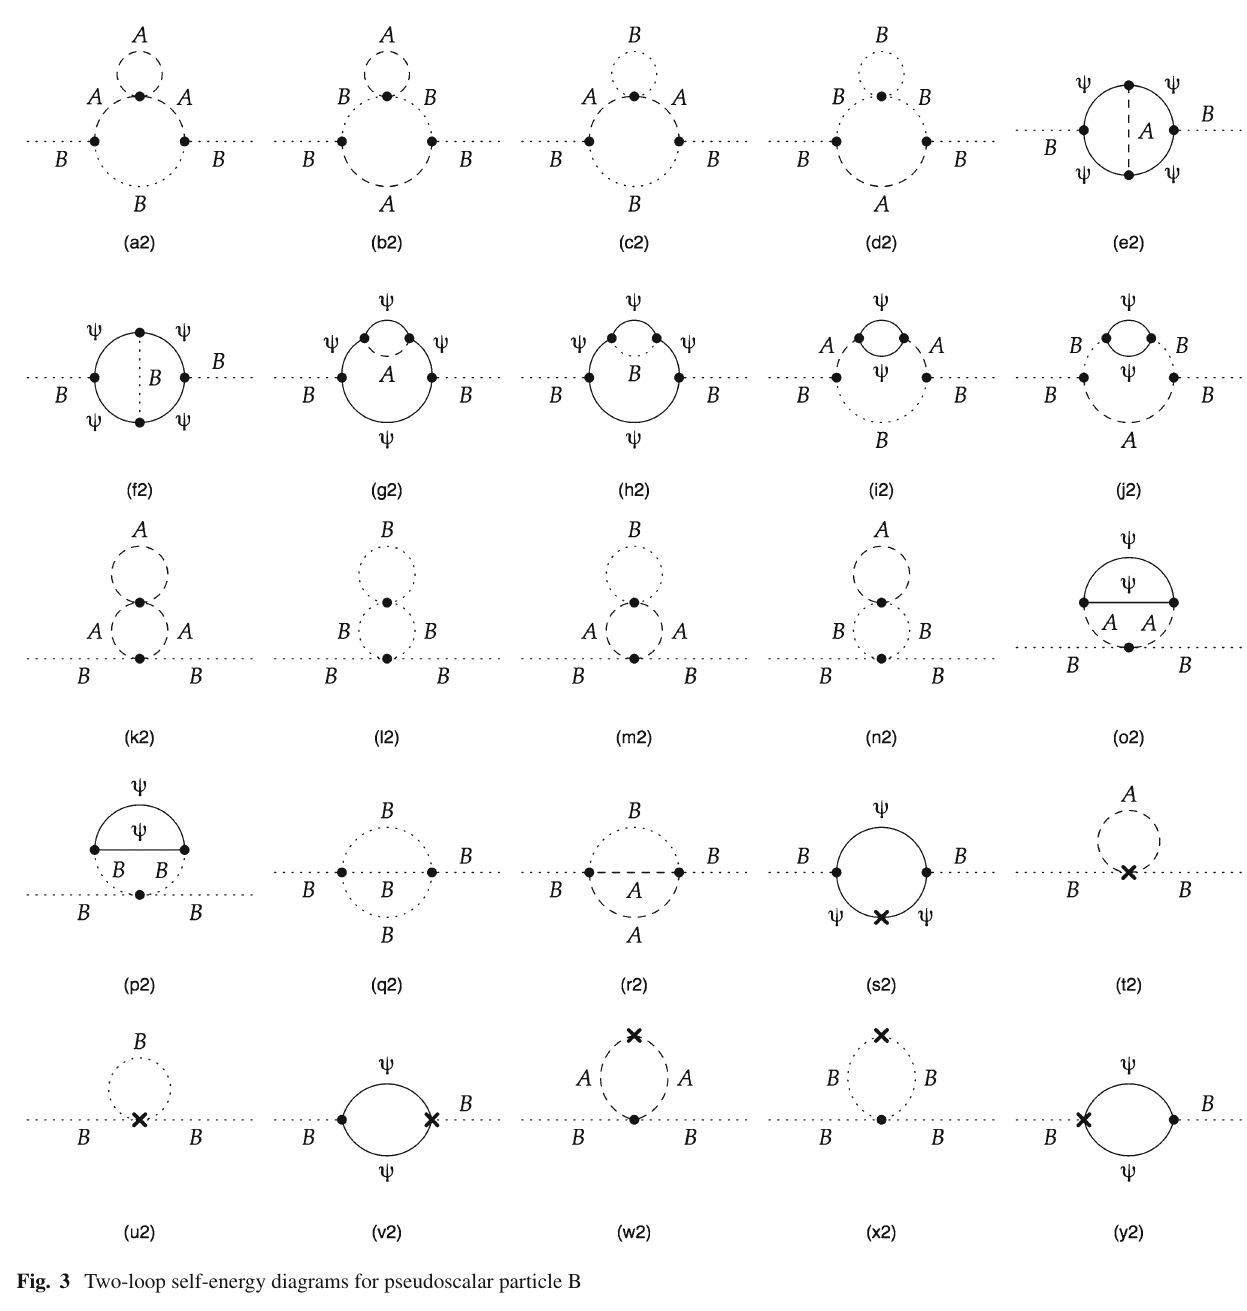
Fig. 3 Two-loop self-energy diagrams for pseudoscalar particle B